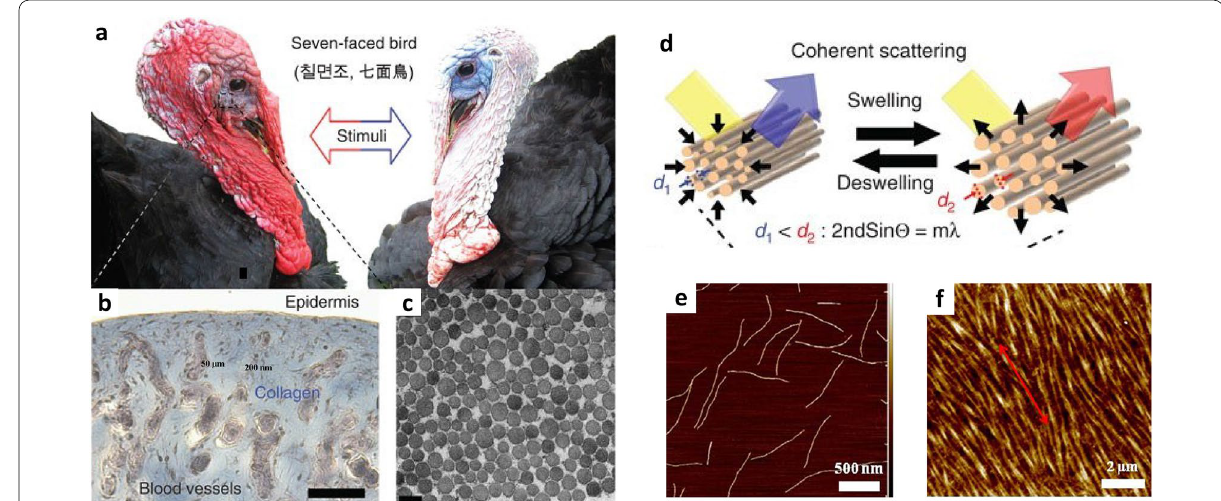
Fig. 1 Biomimetic self‑assembly and colour occurrence. a Colour change of the turkey’s red skin. b Collagen and highly vascularized tissues of the turkey skin. c Transmission electron micrograph of a cross‑section of collagen bundled fibres in the dermis. d Coherent scattering of the collagen fibres in turkey skins. AFM images of e individual M13 bacteriophages and f M13 bacteriophage‑based film. The red arrow in f represents an orientation of self‑assembled M13 bacteriophage bundles. g Genetically engineered M13 bacteriophages to recognize target molecules through self‑assembled structures ( a – d Reproduced with permission from Ref. [54]. Copyright 2014, Nature Publishing Group. e , f Reproduced with permission from Ref. [118]. Copyright 2013, Nature Publishing Group)